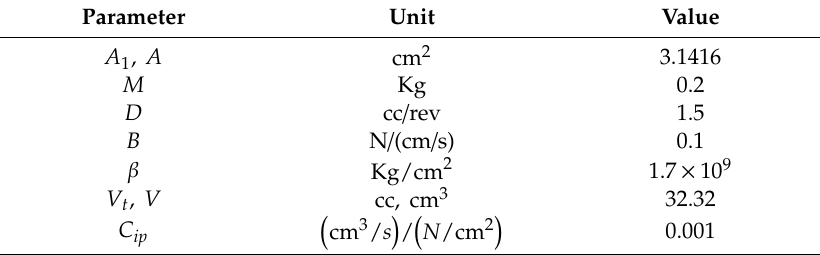
( b ) Figure 12. Comparisons of the experimental results: ( a ) is the position control performance of the SMC (sliding motor control) and the PID control, ( b ) is a comparison of errors. On the other hand, when the moving speed of the cylinder was high, this problem did not occur in the sliding mode control and PID control. However, PID had a larger error than sliding mode control when tracking the position (Figure 12b). The PID controls showed good follow-up, but it is unstable and slower than the designed SMC 1. In case of PID control, the error value has some positive offset in 0–1 s, 3–5 s, and 7–8 s intervals. This is because the applied cylinder is a single rod, not a double rod. In other words, because the volumes of both chambers are different, when the same